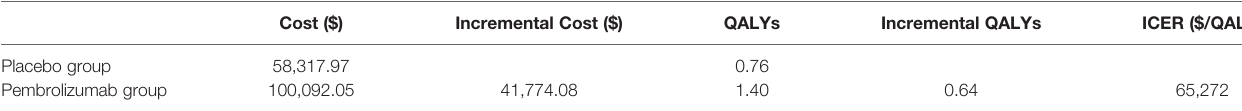
TABLE 3 | Cost-effectiveness Analysis of pembrolizumab group versus placebo group.